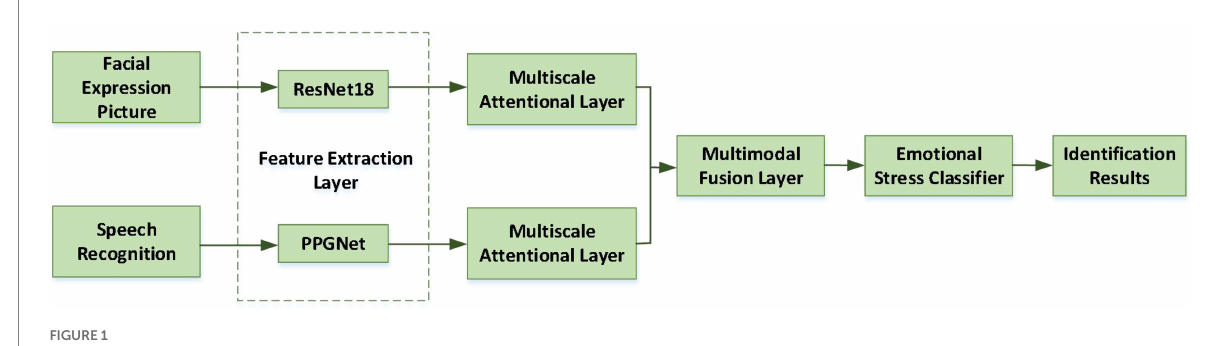
FIGURE 1 Multimodal ER